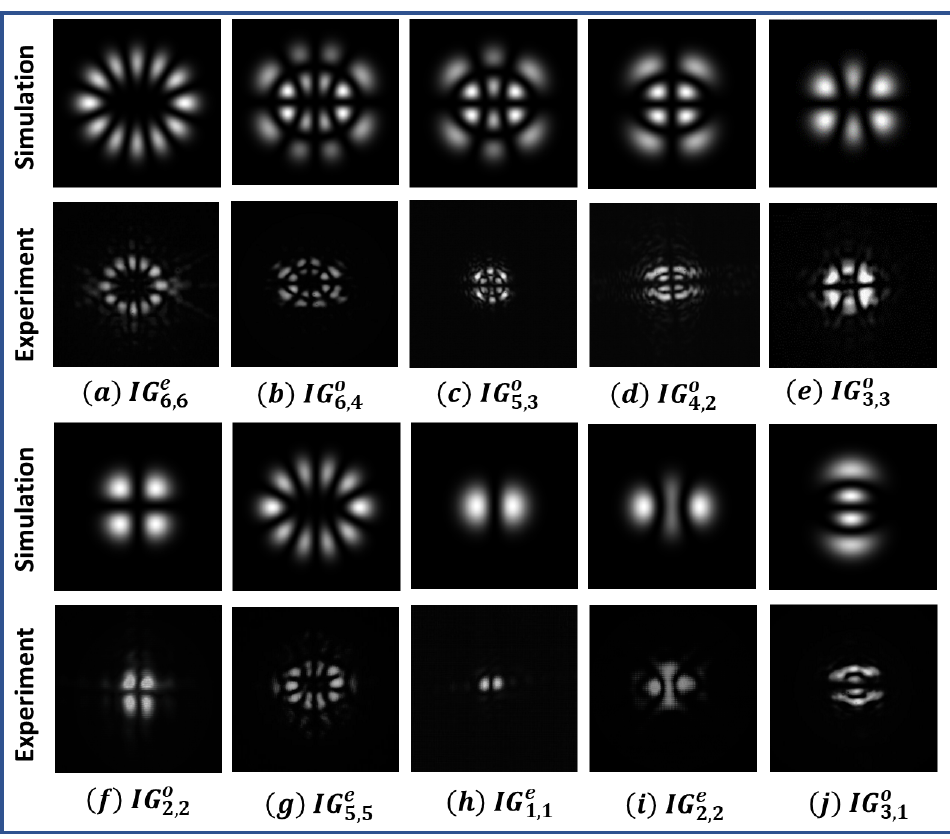
Figure 9. Intensity patterns of simulated and experimentally generated Ince–Gaussian beams ( a ) IG e